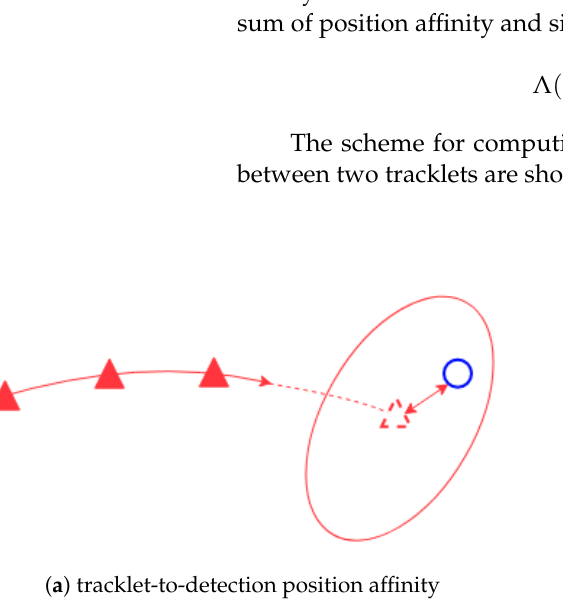
Figure 2. The computational scheme of position affinity. The filled triangles (or rectangles) are subsequent states of a tracklet. The colored arrow represents the time order: the closer to the tip, the more recent the state. The triangle (or rectangle) in dash line is the state propagated forward (or backward) in time. The covariance of these propagated states are denoted by ellipses with the same color. The two-headed arrows indicate the Mahalanobis distance. In the subfigure ( a ), the blue circle denotes a